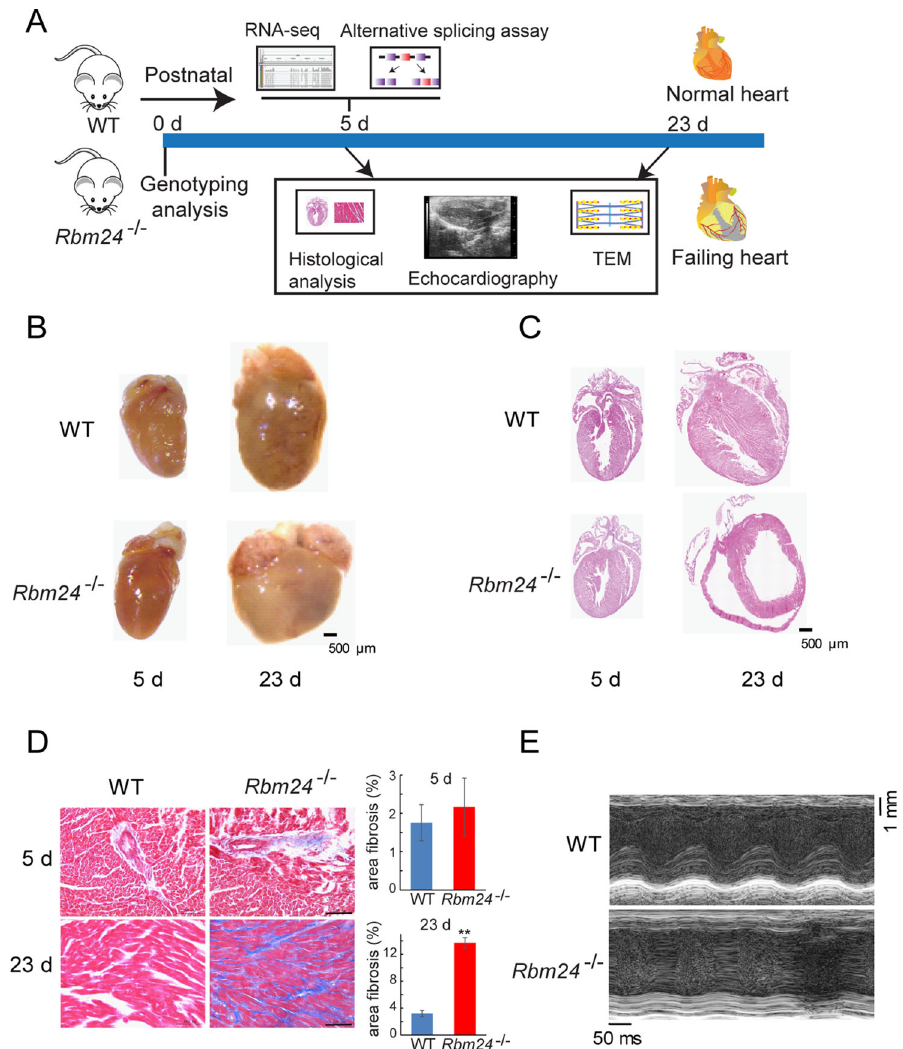
Figure 2. Cardiac-speci fi c RBM24 deletion leads to DCM. (A) Schematic overview of experimental strategy. Assays performed at different time points as described in the Results section are indicated in the diagram. (B) Representative gross morphology of WTand Rbm24 − / − hearts of mice. Scale bar: 500 μ m. (C) Representative cross-sectional images of hematoxylin & eosin staining of hearts from WT and Rbm24 − / − mice. Scale bar: 500 μ m. (D) Left: Representative Masson ’ s trichrome staining of WT and Rbm24 − / − mouse heart sections. Scale bar: 100 μ m. Right: Quanti fi cation of fi brotic area in heart sections displayed on the left, % area fi brosis = the sum of fi brotic area in heart/the sum of myocardial area in heart. The data were expressed as means ± SEM. ** P < 0.01. Data are representative from 5 – 7 mice (B – D). (E) Examples of cardiac echocardiography of WTand Rbm24 − / − mice at postnatal day 25. Scale bar: 1 mm. See also Videos S1 –